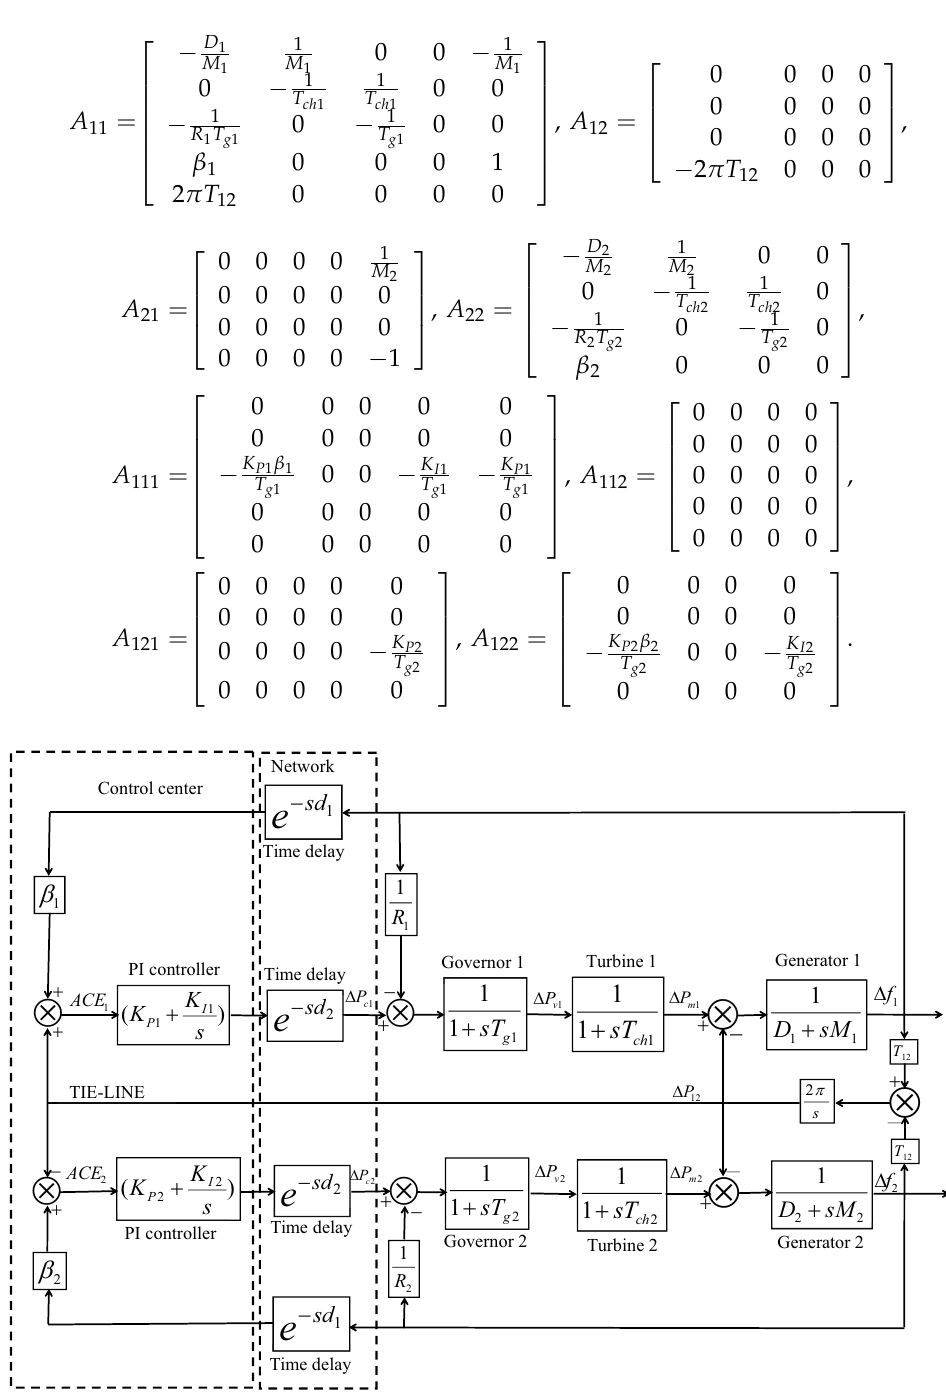
Figure 2. The basic diagram of the simplified LFC of two-area power